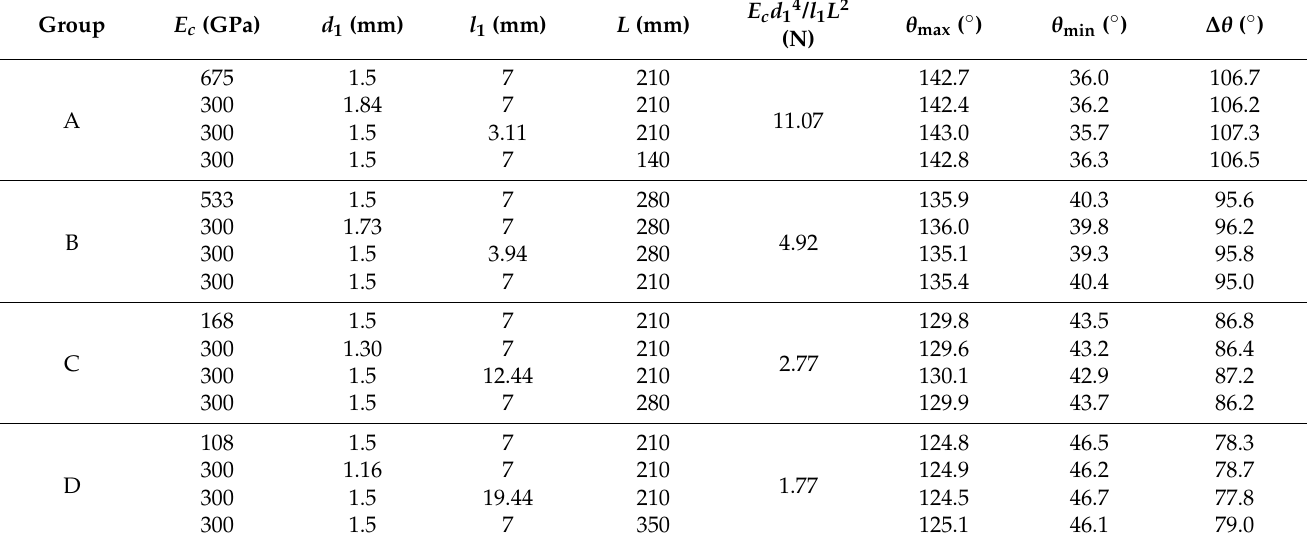
Table 6. Maximal and minimal critical wrinkling angle of the skins with various CFRP reinforce- ment